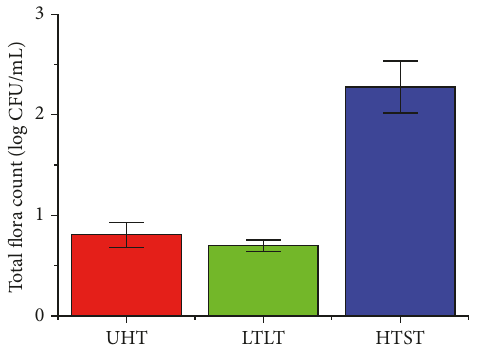
Figure 1: Effect of thermal treatments on the total flora counts of the watermelon juice. UHT: ultrahigh temperature; LTLT: low temperature long time; HTST: high temperature short time.